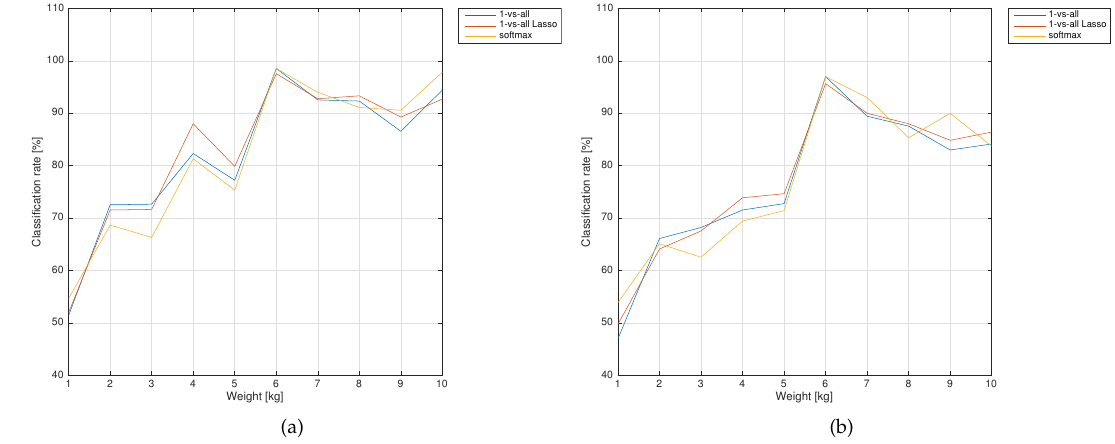
Figure 8. Performance of the proposed model with real weight ( a ) and estimated weight ( b ).